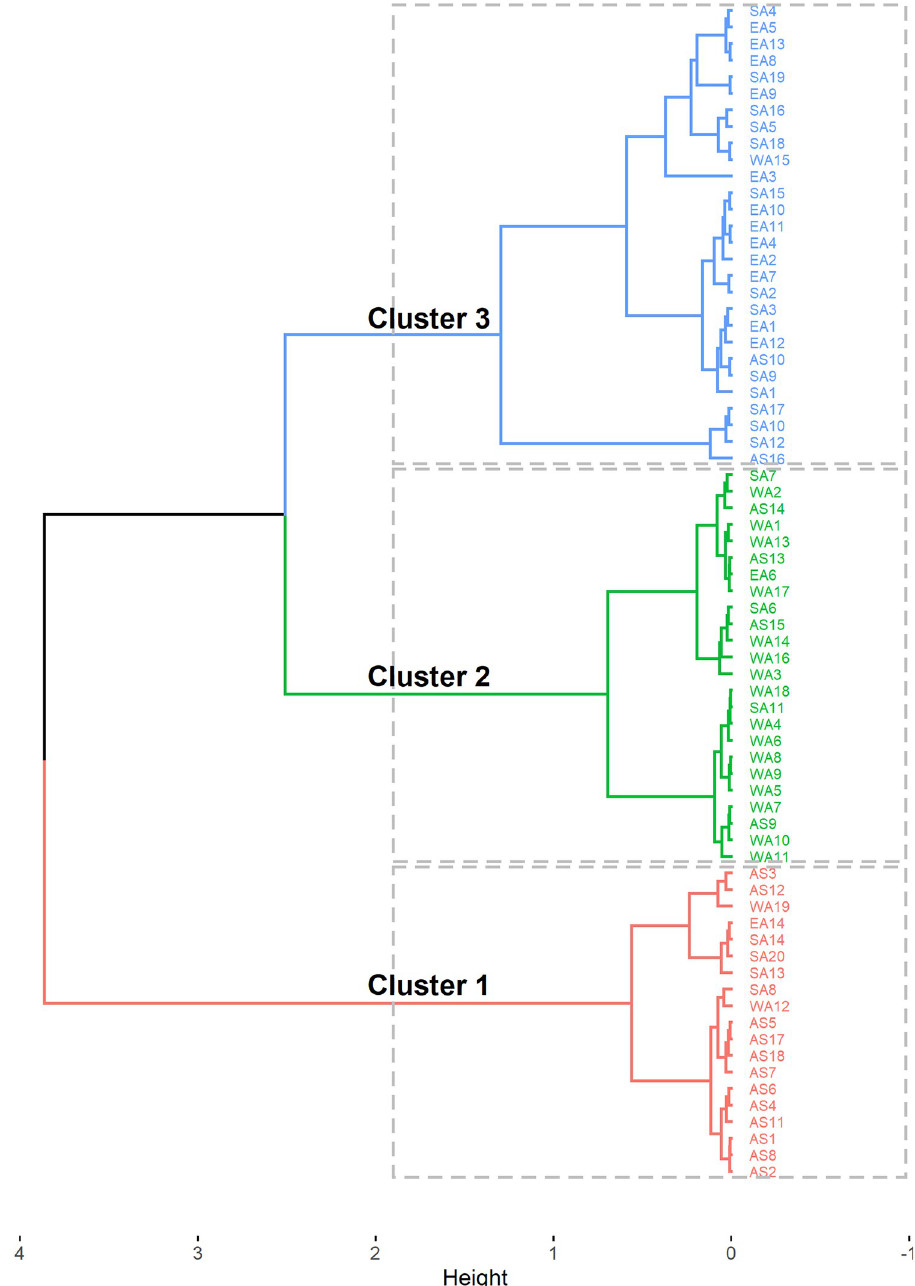
Fig 4. Dendrogram showing the lines constituting the three clusters. AS: Asia; EA: East Africa; SA: Southern Africa; WA: West Africa. plants, with a moderate number of short primary branches, low biomass productivity and dry matter content, relatively late flowering time, small leaves, and high harvest index (Table 5). Cluster 2 included mainly lines originating from West Africa (73.68% of all West African lines) and some from other regions. Genotypes in cluster 2 had high dry matter content, long primary branches, high biomass productivity, low number of primary branches, moderate